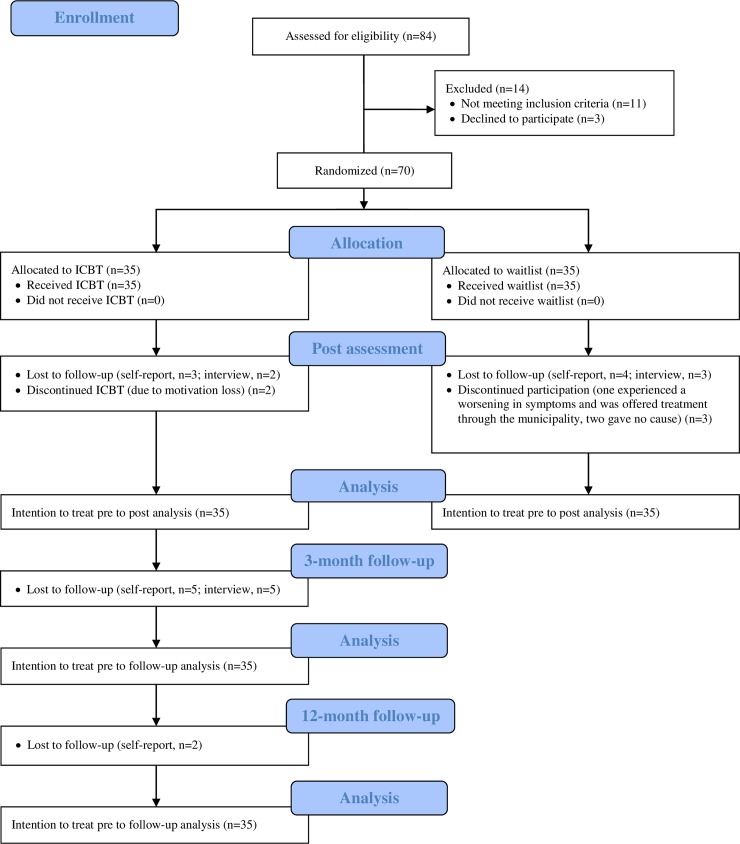
Study flow-chart.